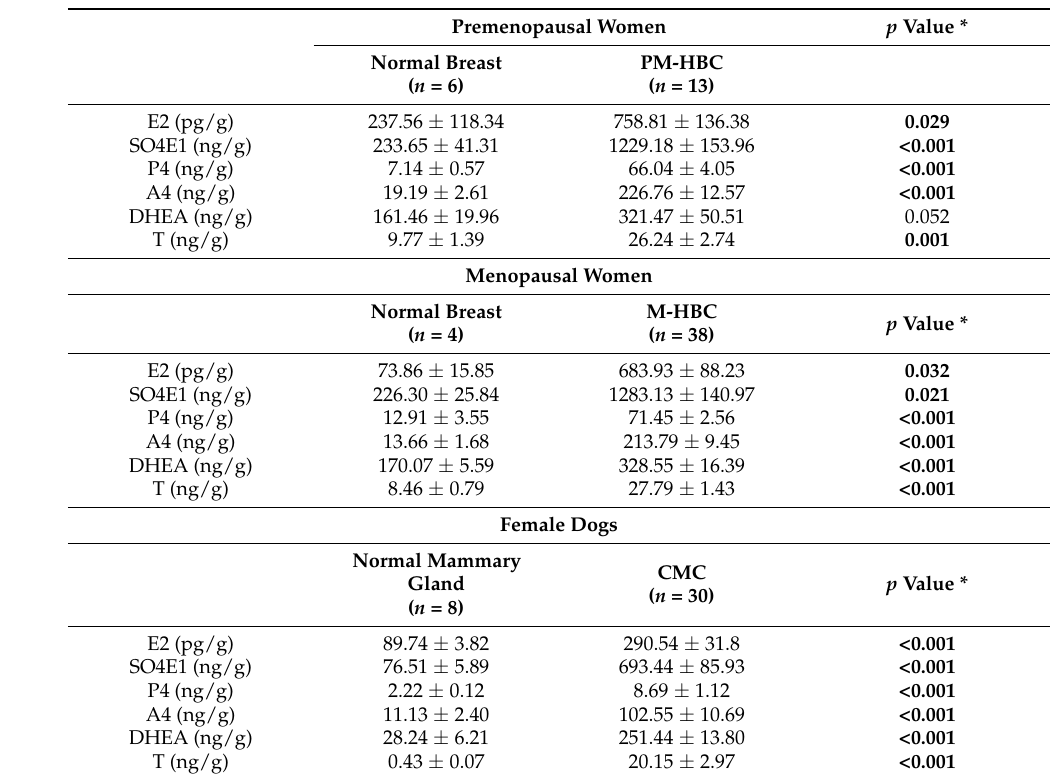
Table 4. Hormone concentrations (mean ± S.E.M) in breast/mammary tissue homogenates from women and dogs included in the